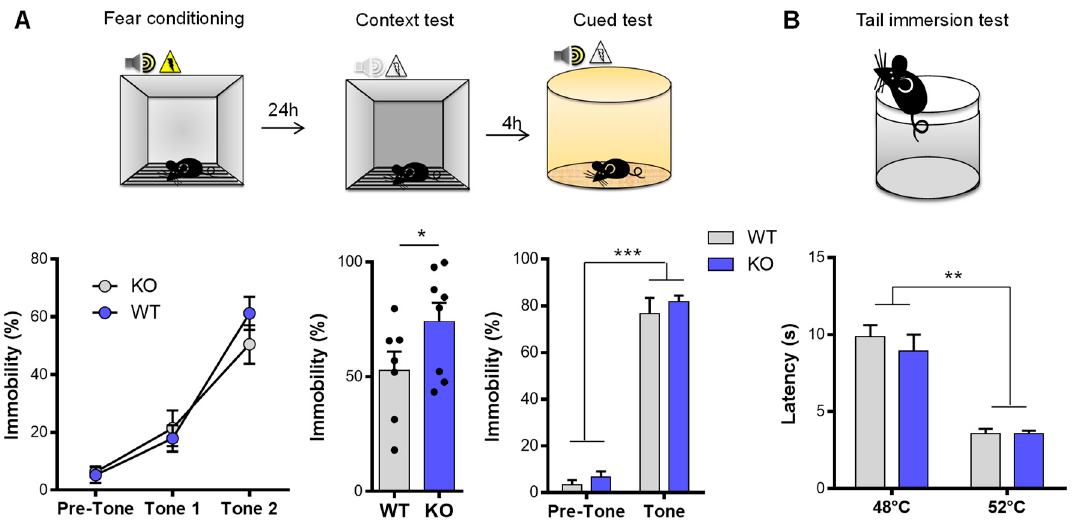
Figure 2. Emotional memory and nociception in VMAT2 DBHcre mice. ( A ) Percentage of immobility time during the 2 min adaptation period and the two pairings (2 min ITI) of a 30-sec tone (80 dB) ending with a 2 sec 0.5 mA foot shock in VMAT2 DBHcre WT (n = 7) and KO (n = 8) mice (genotype: F (1,13) = 0.17, p = 0.69; tone: F (2,26) = 76.20, ** p < 0.01, *** p < 0.001; genotype × tone: F (2,26) = 1.67, p = 0.21; left). Percentage of immobility during the 3 min of the contextual fear memory test performed 24 h after the fear conditioning (t 13 = 2.86, * p = 0.013; middle). Percentage of immobility during the 2 min habituation and the 30 sec tone (80 dB) in the cued memory test performed 24 h after the fear conditioning (genotype: F (1,13) = 1, p = 0.33; tone: F (1,13) = 365.25, p < 0.001; genotype × tone: F (1,13) = 0.053, p = 0.82; right). ( B ) Latency (s) to respond to the heat stimulus with vigorous flexion of the tail when the water temperature is maintained at 48 ◦ C for a first session and then at 52 ◦ C in VMAT2 DBHcre WT (n = 10) and KO (n = 9) mice (genotype: F (1,17) = 0.44, p = 0.52; temperature: F (1,17) = 92.91, *** p < 0.001; genotype × temperature: F (1,17) = 0.57, p =